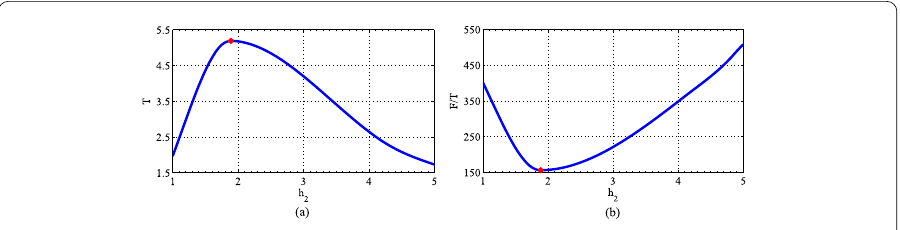
Figure 8 The change in the period T and the cost per unit time F/T on the economic threshold h 2 . (a) The change in the period T on the economic threshold h 2 . (b) The cost per unit time F/T on the economic threshold h 2